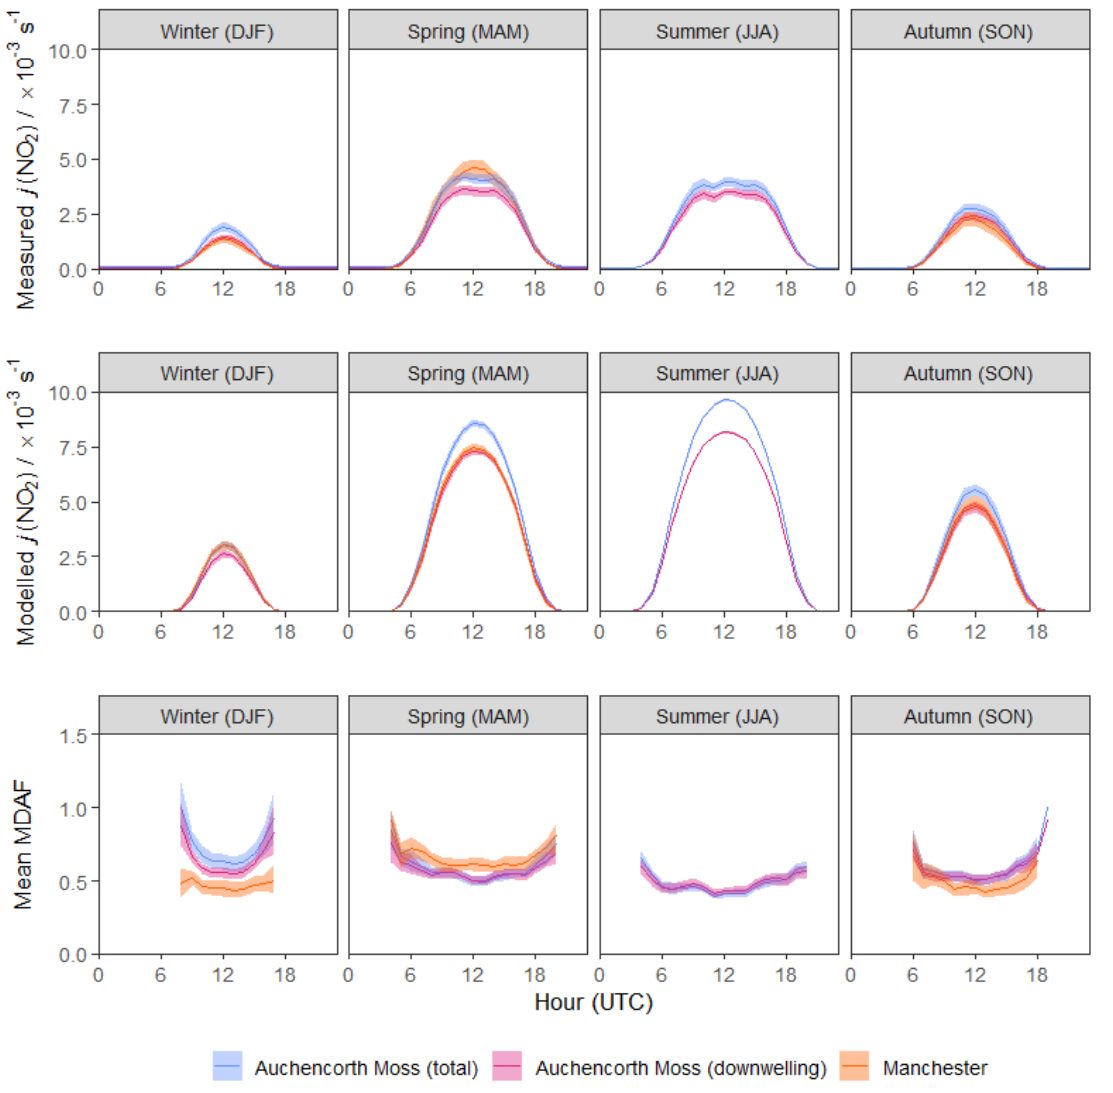
Figure 6. Seasonal mean diurnal profiles of measured j (NO 2 ), modelled j (NO 2 ) and MDAF values at the Auchencorth Moss and Manchester sites. The shaded areas are the 95% confidence intervals of hourly data. There is no summer season data for Manchester.